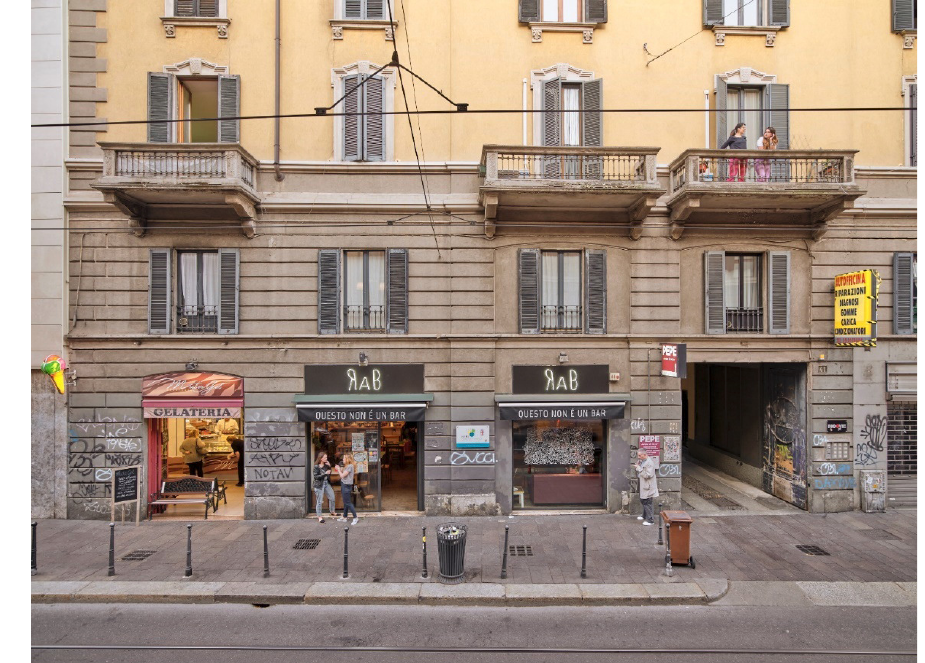
Figure 2. RAB–WeMi San Gottardo, streetscape. Source: Courtesy of Giovanni